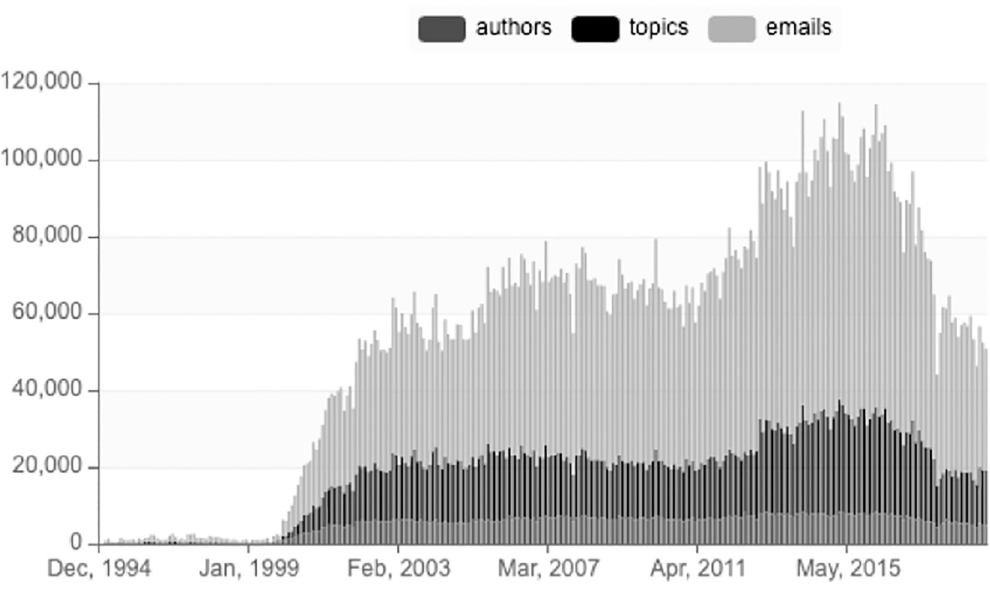
Fig 1. Emails, topics and authors. Source: https://projects.apache.org/statistics.html.